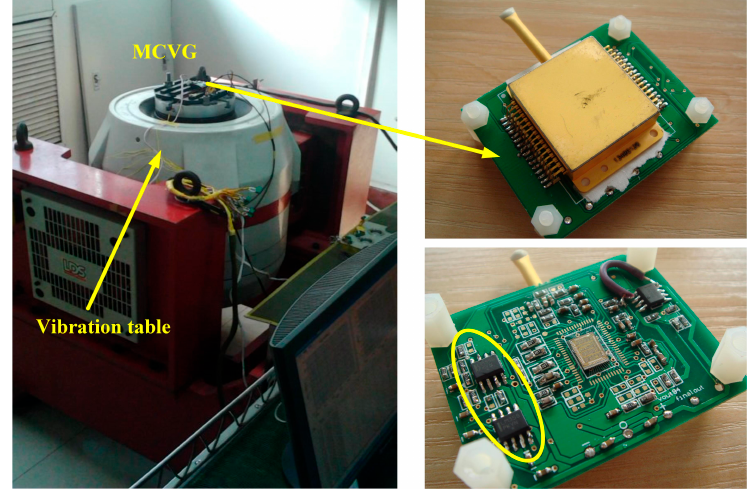
Figure 8. Vibration test system including vibration table and MCVG in vacuum; the signal processing element with oscillation suppression is marked in the yellow circle.